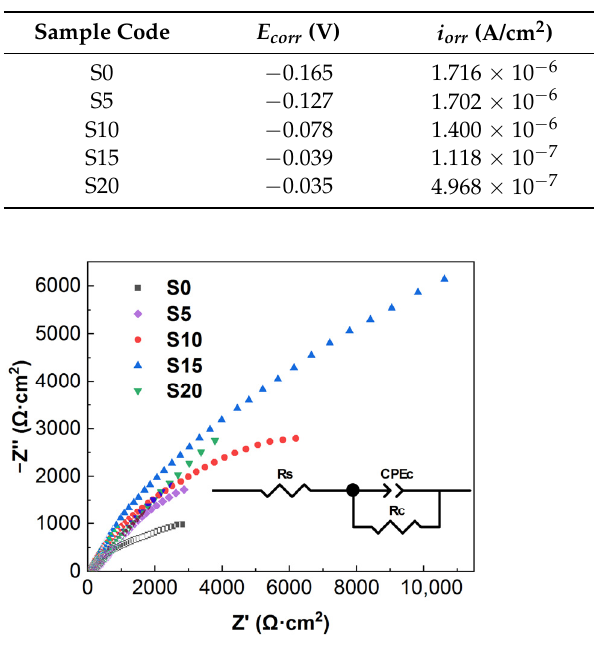
Figure 9. Nyquist plots of all samples. Table 4. R values obtained by fitting Nyquist plots with equivalent